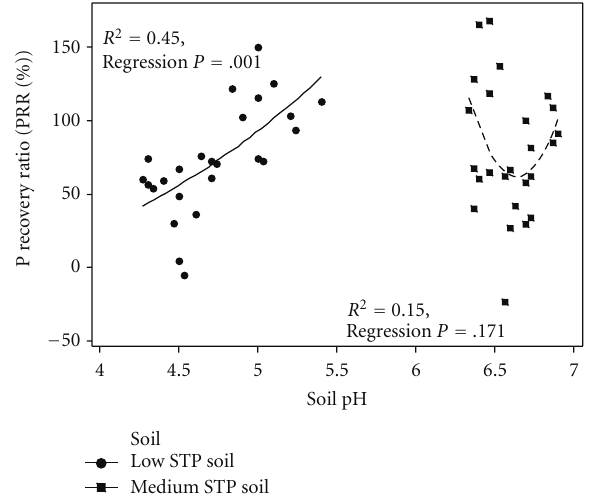
Figure 2: Plot of the percentage of P-Recovery Ratio versus Soil pH along with fitted second order polynomial regression line. The data points are averages of the three replication of the P treatment by incubation time